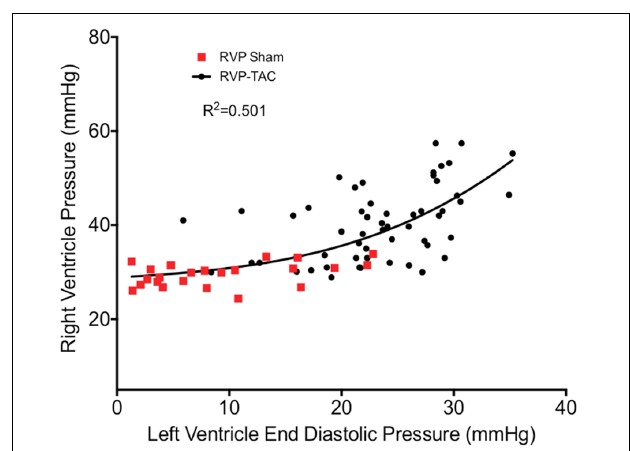
FIGURE 8 | Correlation plot between right ventricle systolic pressure and left ventricular end diastolic pressure in both sham ( n = 23) and TAC ( n = 55). The curve of best fit was drawn using a non-linear third order polynomial (cubic)